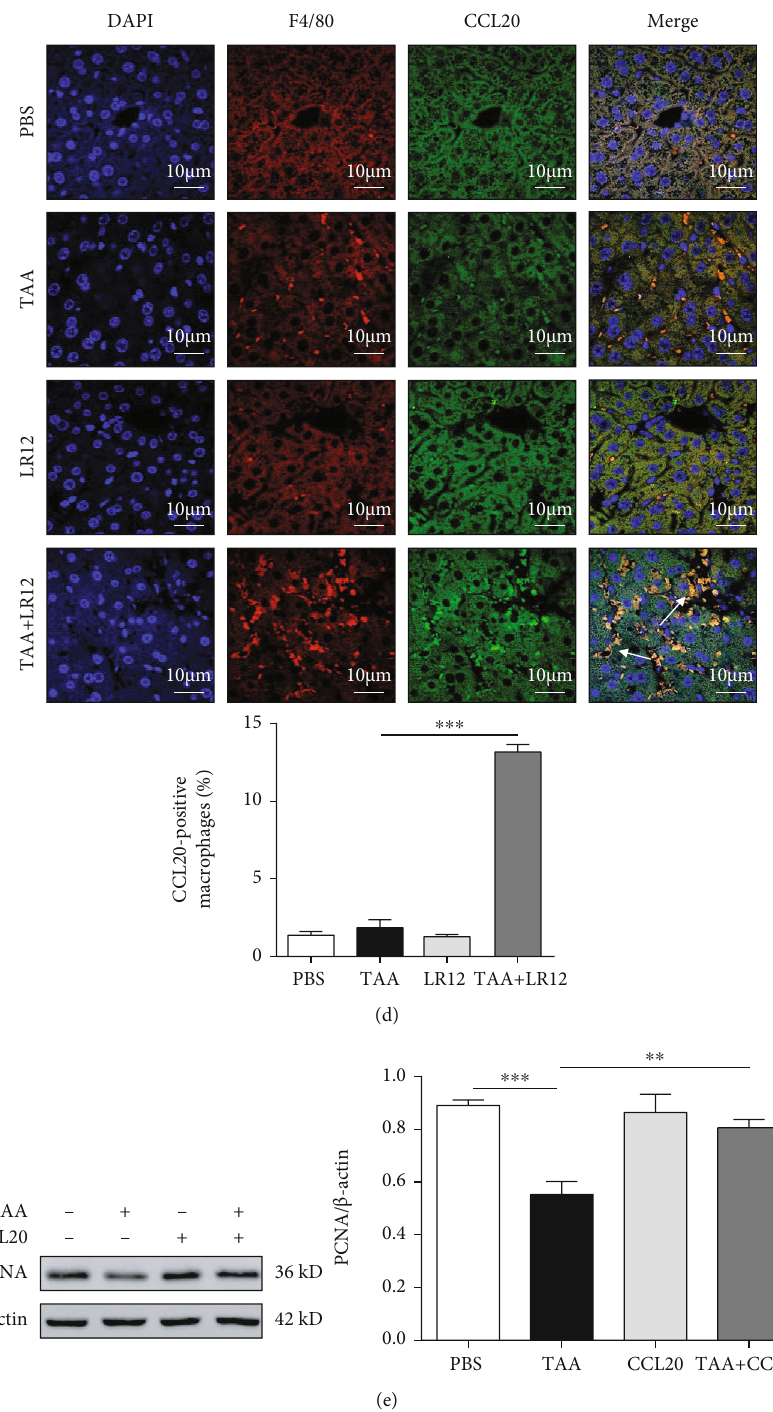
Figure 5: LR12 promoted hepatocyte regeneration via CCL20 secreted by macrophages. (a) The cytokine protein microarray of the supernatant from macrophages. (b) ELISA of CCL20 in the supernatant from macrophages. (c) The mRNA level of CCL20 in macrophages. (d) CLSM showing F4/80 and CCL20 staining in the liver tissues. (e) Western blot analysis of PCNA in LO2 cells stimulated with CCL20. Data were presented as the mean ± standard deviation (SD). ∗ P < 0 : 05 , ∗∗ P < 0 : 01 , and ∗∗∗ P < 0 : 001 versus control